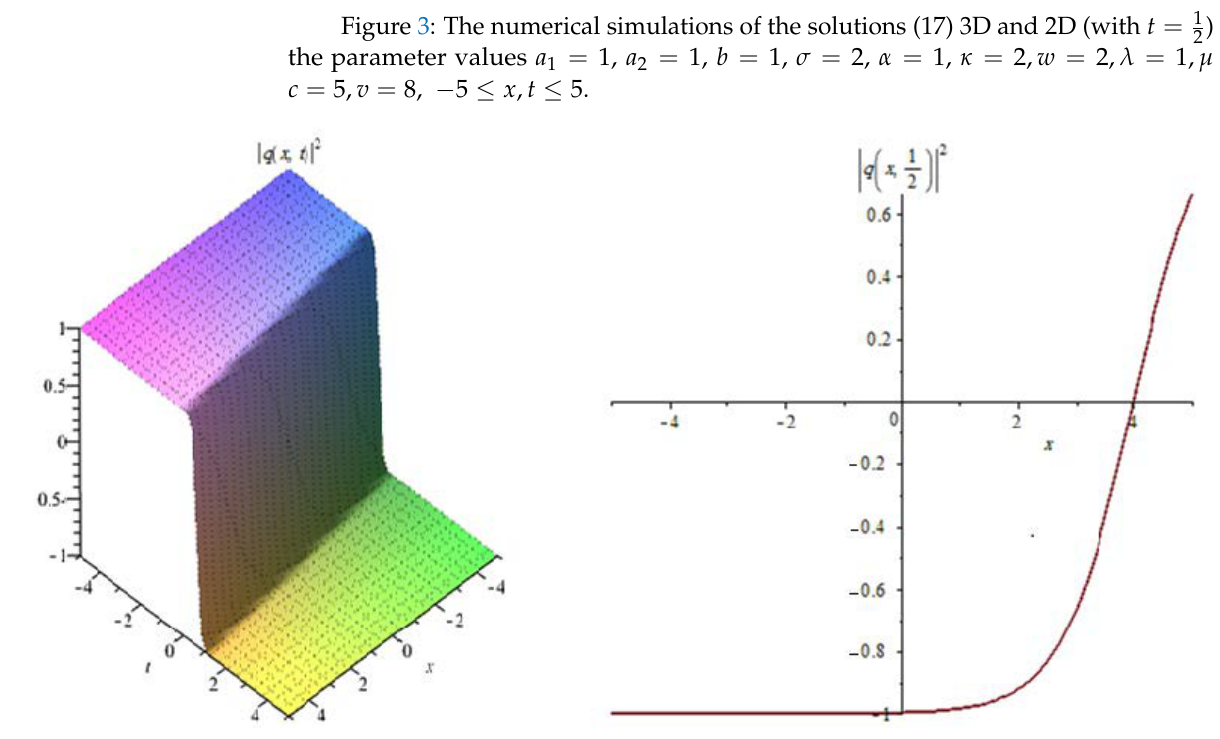
Figure 4: The numerical simulations of the solutions (19) 3D and 2D (with t = 1 the parameter values a 1 = 1, a 2 = 1, b = 1, σ = 0, α = 1, κ = 2, w = 2, λ = 1, µ = 1, c = 5, v = 3, x , t 5 5. − ≤ ≤